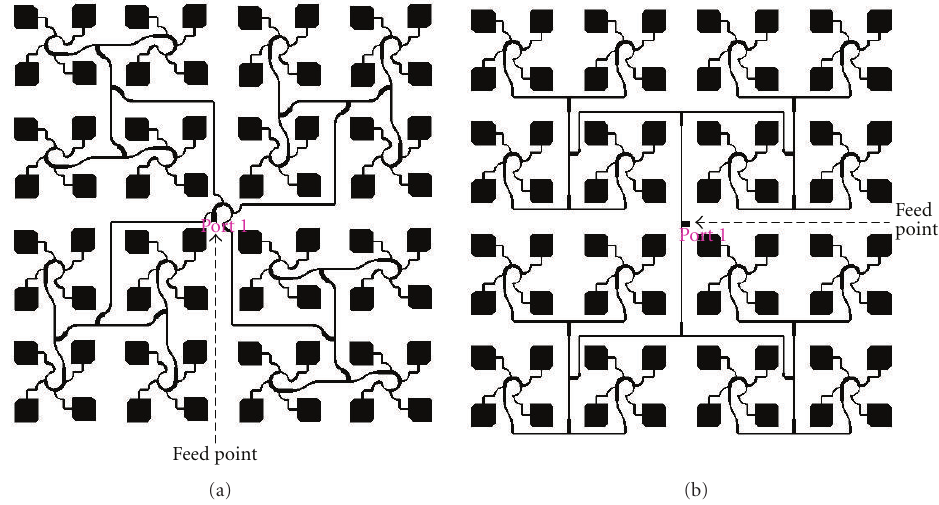
Figure 3: 64-element CP antenna arrays; (a) with the proposed double series-parallel sequential rotation feeding network; (b) with the conventional parallel feeding network.